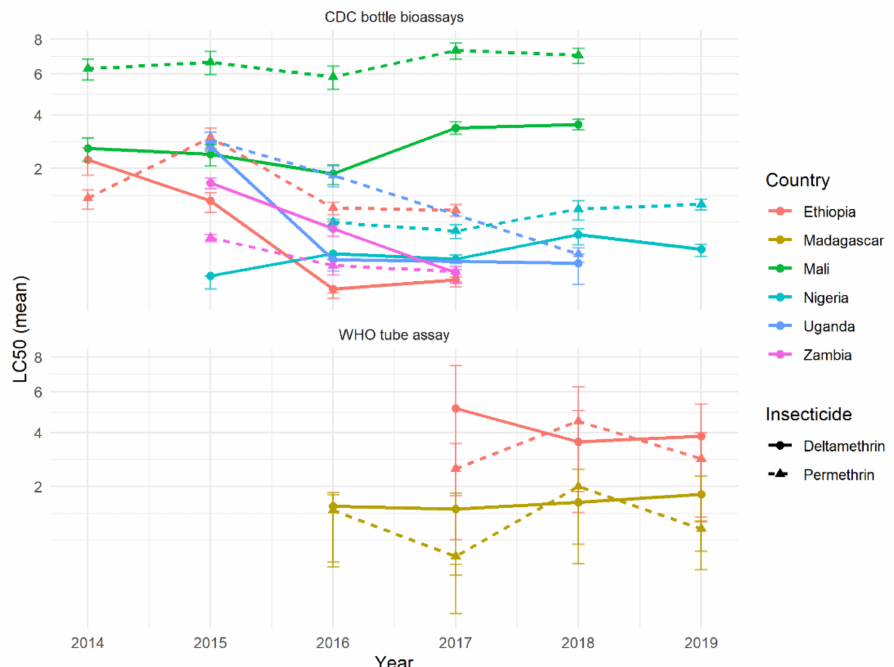
Figure 12. Country-specific mortality trends over time for countries with data from 3 or more consecutive years for both insecticides (per assay type). Mean LC 50 values for each insecticide per country are shown for each assay and year. Different colours represent different countries, and each insecticide is shown by point and line type (permethrin in triangles and dashed lines, and deltamethrin in point and solid lines). Ninety-five credible interval estimates for the mean LC 50 estimates are shown with the vertical whiskers, whilst horizontal lines link countries (though sites varied within countries over